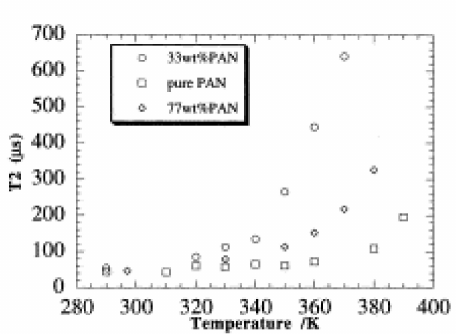
Figure 10. T 2 relaxation as a function of temperature for pure polyacrylonitrile (PAN) and PAN electrolytes containing 30% and 67% by weight LiTf. T g was designated as the temperature where T 2 relaxation changed significantly which was indicative of significant polymer chain motion. Reprinted from [87]. Copyright 2000 with permission from